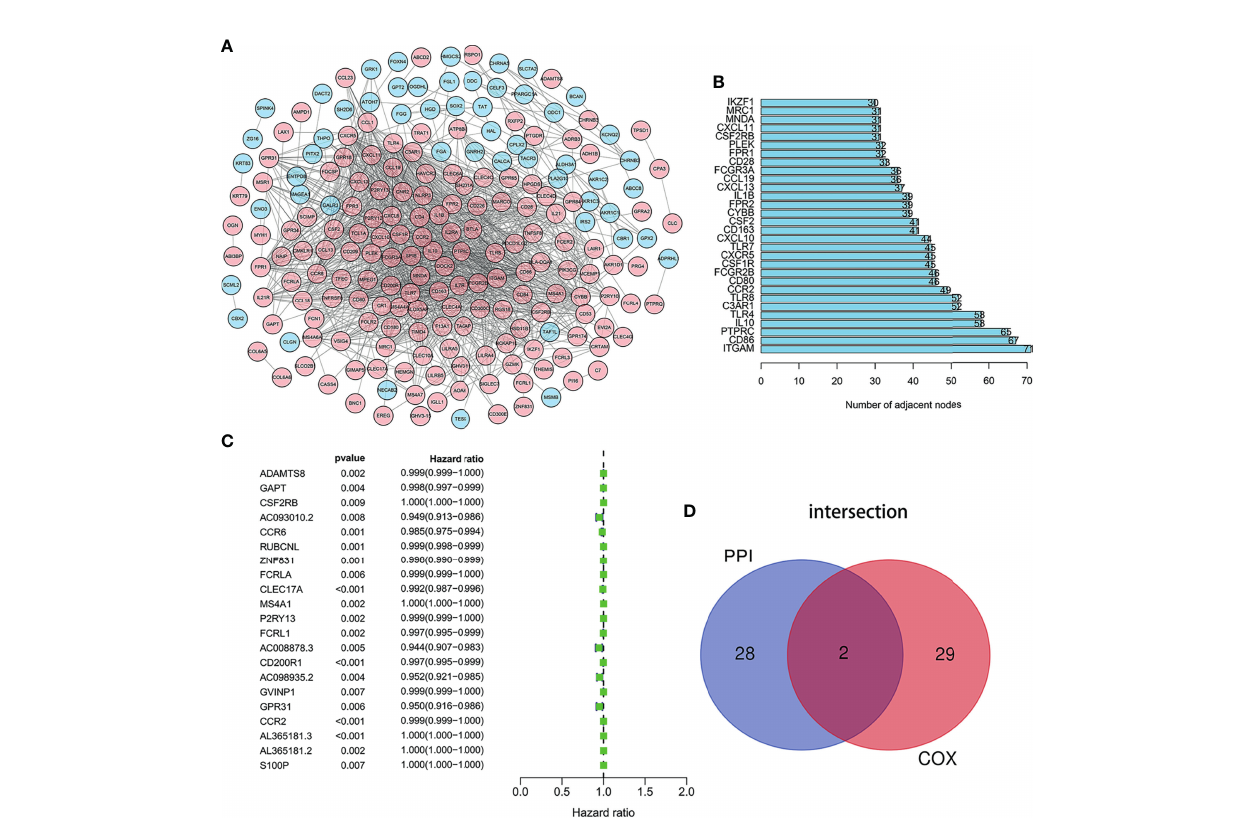
FIGURE 3 | Intersection analysis of PPI network and univariate COX regression analysis. (A) The interaction between IRGs. (B) Top 30 genes most connected to other genes. (C) Univariate Cox regression analysis was performed on the survival of 379 LUAD patients to determine the signi fi cant genes affecting the survival of LUAD patients. (D) the intersection analysis between the leading nodes in the PPI network and the top 16 genes in the p-value in the univariate Cox